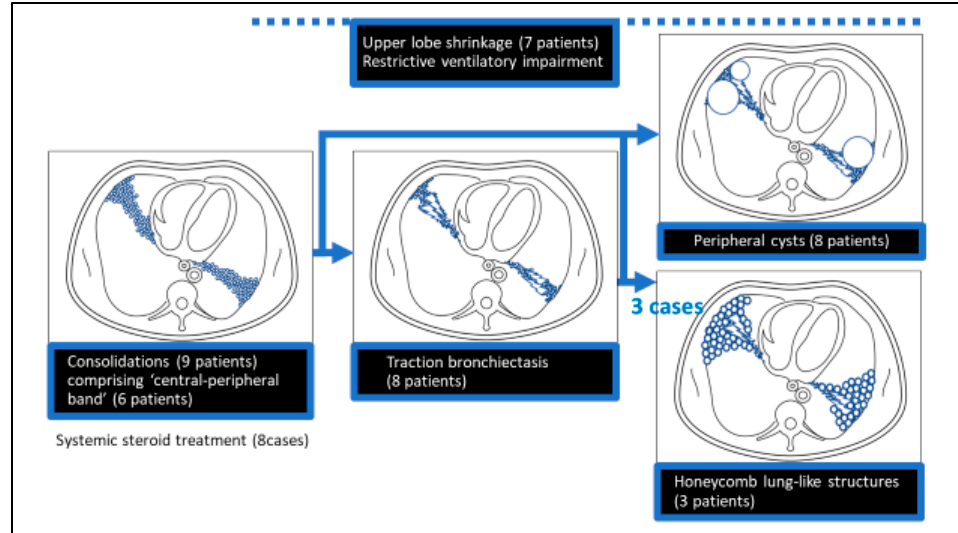
Figure 2. Postulated schema for the pathogenesis of peripheral cysts and honeycomb lung-like structures. Among the nine patients with consolidations, six patients had ‘central-peripheral band’, eight patients had traction bronchiectasis, eight patients had peripheral cysts, seven patients had upper lobe shrinkage, and three patients had honeycomb lung-like structures.